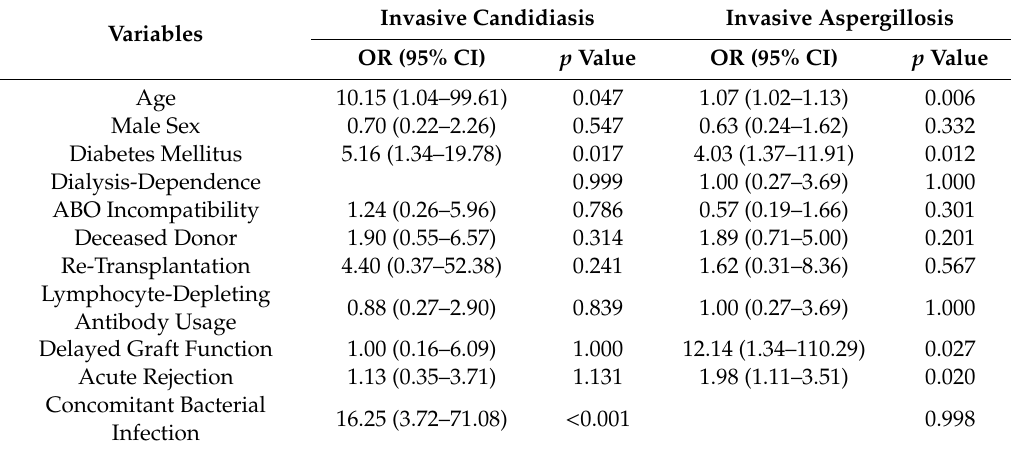
Table 5. Risk factors for invasive candidiasis and invasive aspergillosis (univariate